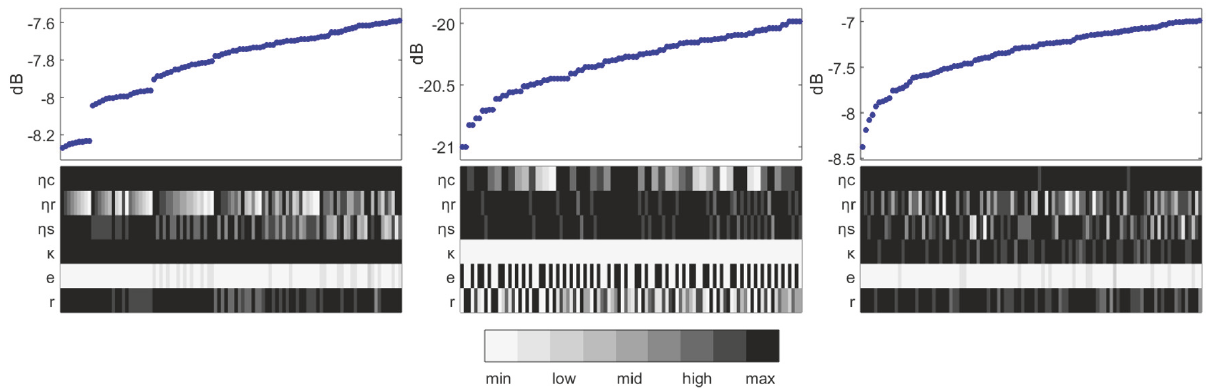
Figure 5: 100 lowest values of normalised kinetic energy level of a resiliently coupled system source-receiver. Left: source; middle: receiver; right: entire system.